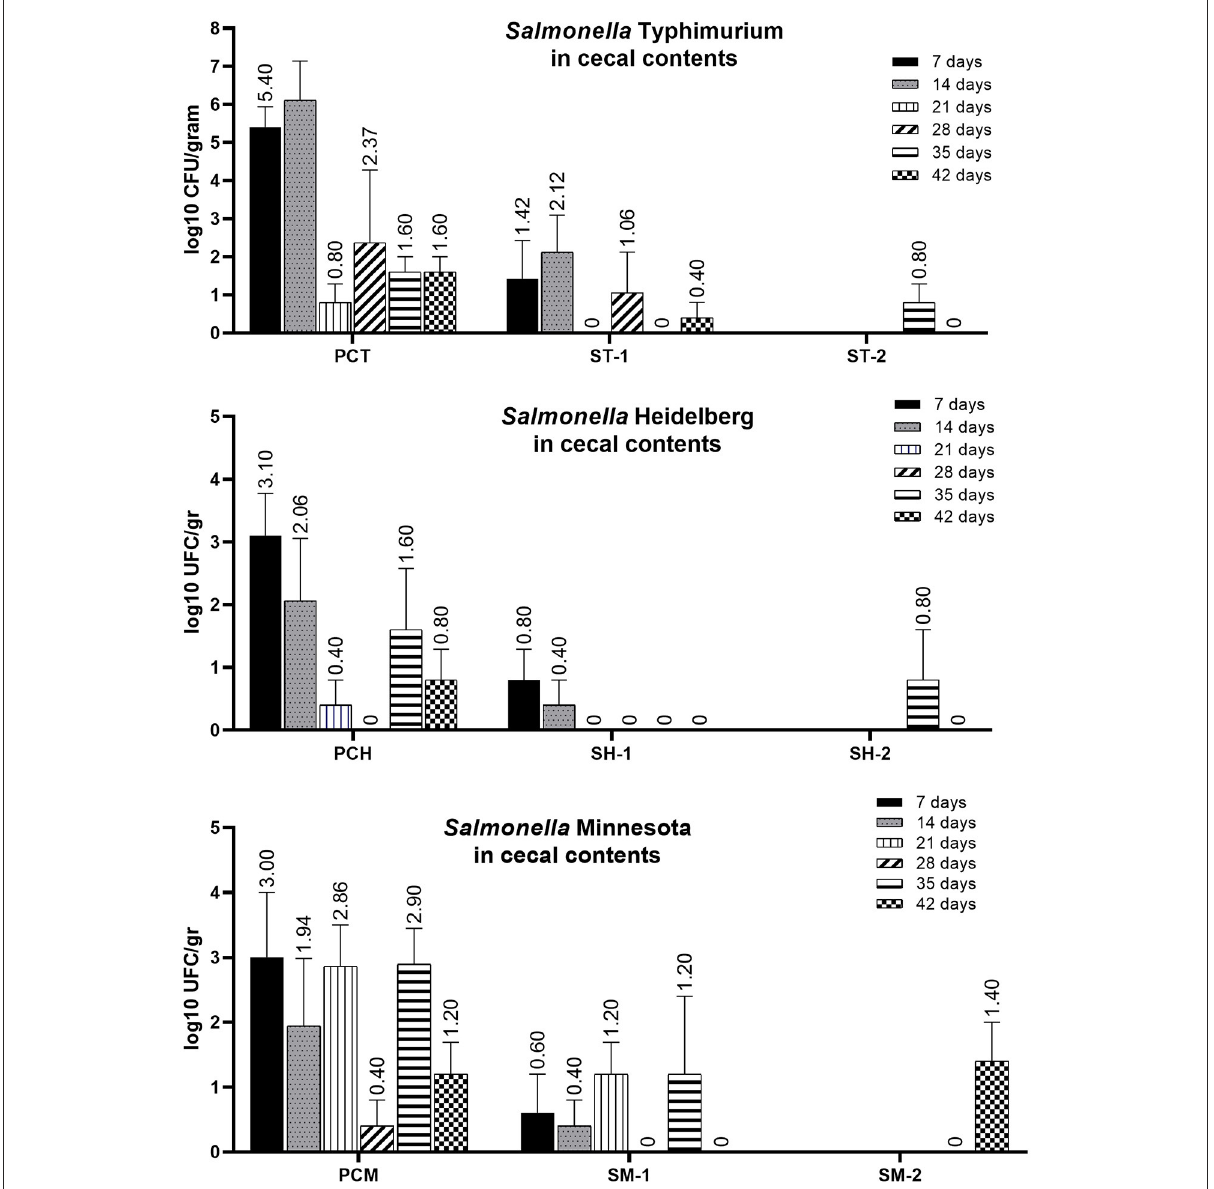
FIGURE1 Bacterial numbers of SH, ST and SM in caecal contents, after challenge of 3 days-old and 33 days-old broilers in groups SH-1, ST-1 and SM-1 (treated from 1 to 21 days-of-age and from 35 to 42 days-of-age), SH-2, ST-2 and SM-2 (treated from 35 to 42 days-of-age) and positive control groups PCH, PCT and PCM